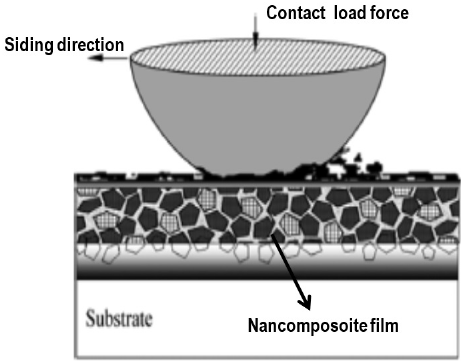
Figure 6: Schematic of a tough nanocomposite coating for cohesive and adhesive toughness [19, 102]